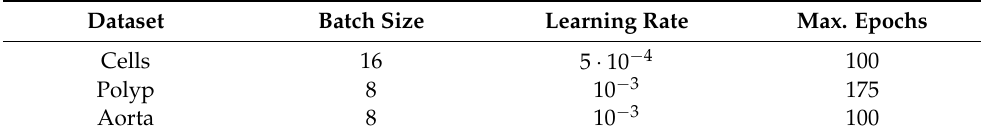
Table 1. The hyper-parameters used for each of the models in our